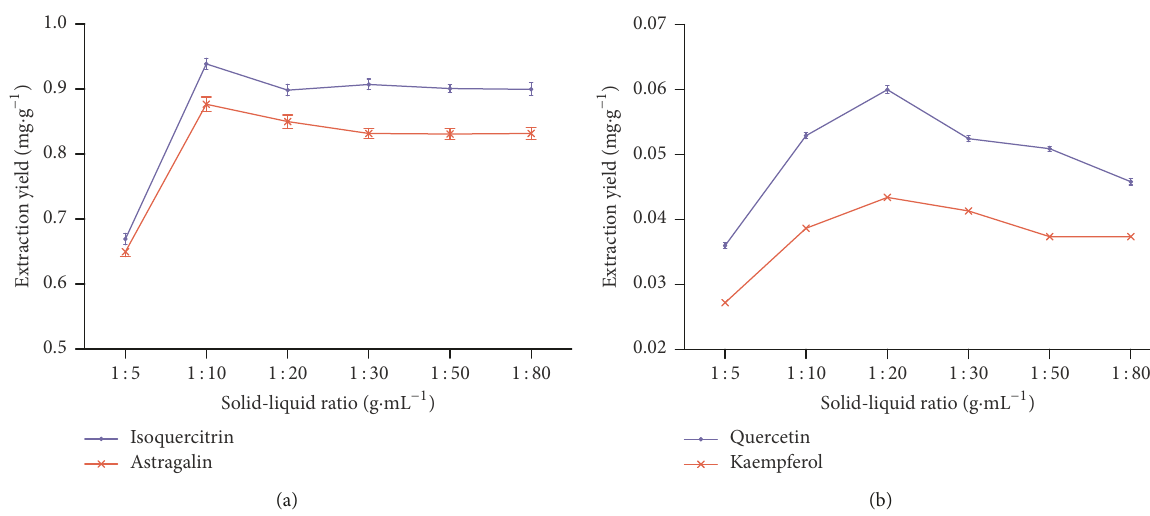
Figure 6: Effect of solid-liquid ratio on extraction yields. Type of IL: [BMIM]BF 4 ; concentration: 0.5 mol ⋅ L −1 ; the particle size: 24 mesh (a) and 40 mesh (b); ultrasound time: 30 min; ultrasound power: 500 W; centrifugation speed: 5000 r ⋅ min −1 .